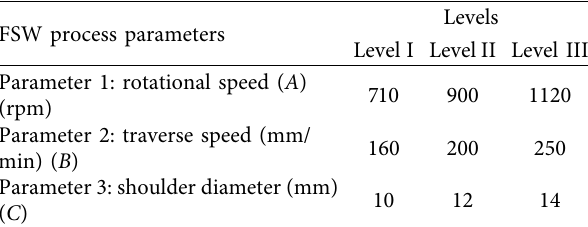
Table 3: FSW process parameter